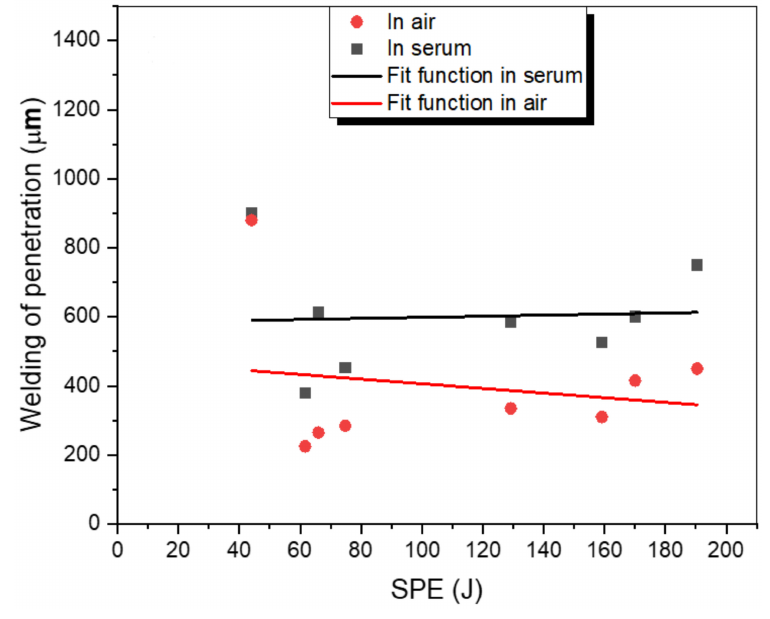
Figure 11. The variations in the penetration depth ( µ m) with